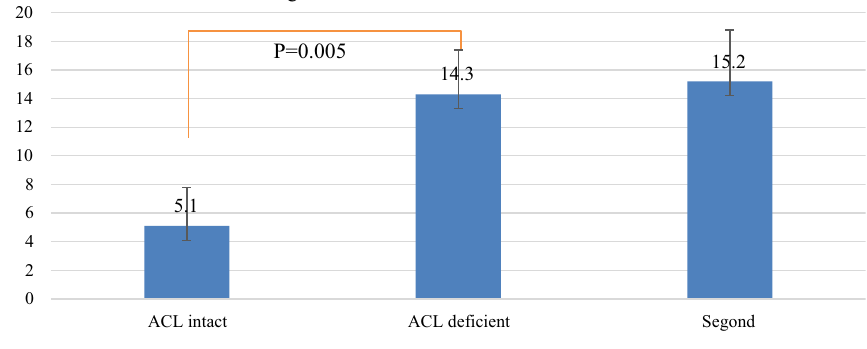
Fig. 3 Intra- and extra-tibial rotation (static measurements)